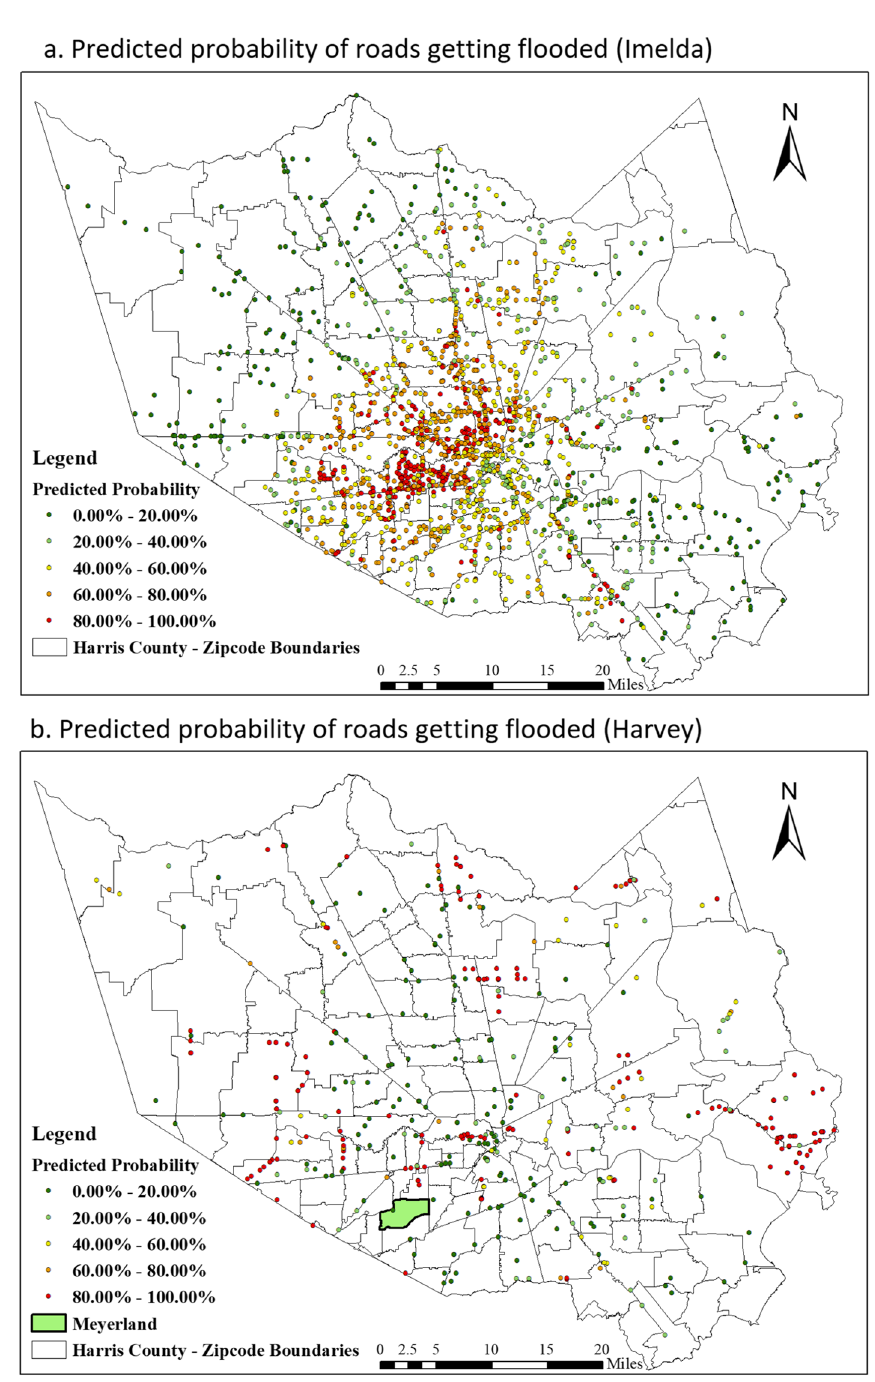
Fig. 7 Examples of predictions of probabilities for roads becoming flooded in Tropical Storm Imelda ( a ) and Hurricane Harvey ( b